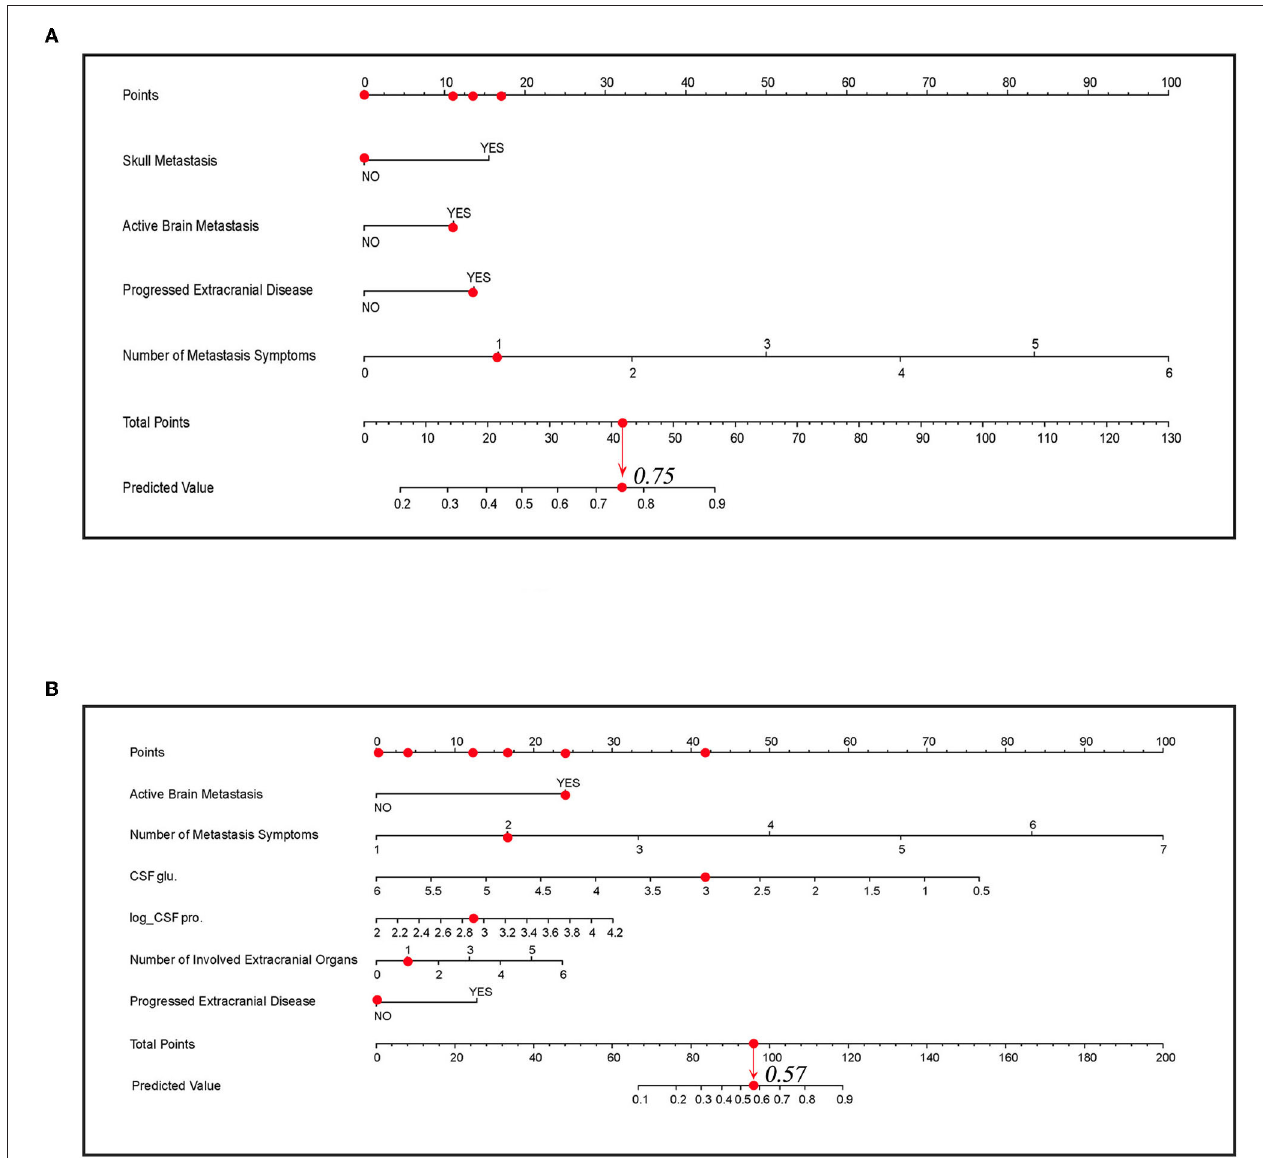
FIGURE 5 | The nomogram for predicting LM. (A) The nomogram of model A. (B) The nomogram of model B. The scores for each predictor correspond to the uppermost point axis (the red dots on the top line). The total point line is at the bottom, and each predictor point was summed to get the total points (the red dot on the total point line). Then, the prediction value was obtained. For example, in (B) , when a patient presents active brain metastasis, two LM symptoms, one involved extracranial organ, and the value of glucose and log-transformed value of proteins in cerebrospinal fluid (CSF) is 3 and 2.9, he will get a point of 87 and the corresponding prediction value is 0.57. glu, glucose; pro., protein; Log_CSF pro, log transformed value of protein in